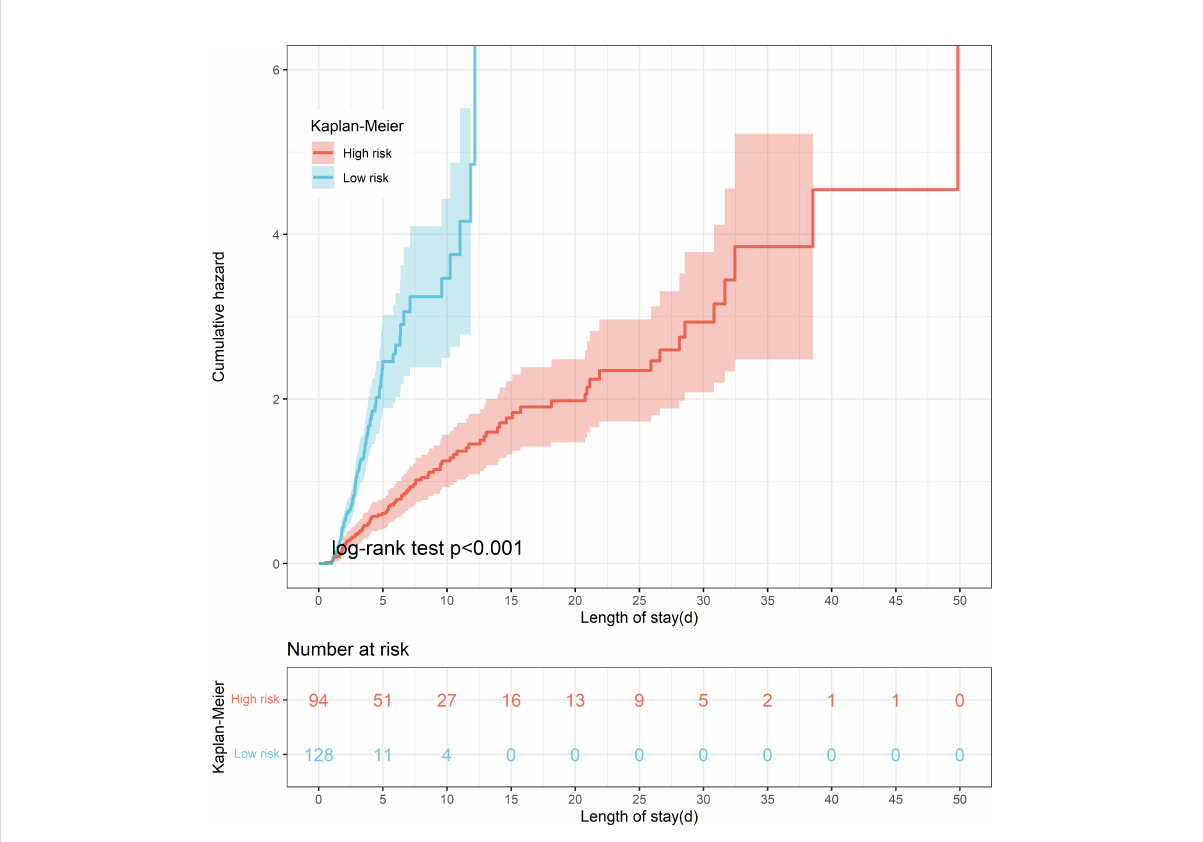
FIGURE 8 Kaplan-Meier curve shows cumulative hazard strati fi ed by risk strati fi cation system (P < 0.001, Log-rank test). “ Sky bule ” indicates patients in the low-risk group; “ Red ” indicates patients in the high-risk group.